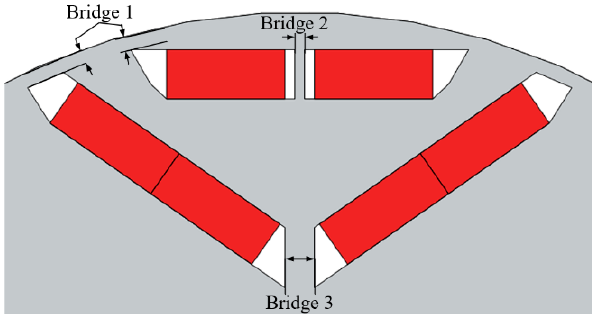
Figure 9. Rotor magnetic bridge schematic diagram.